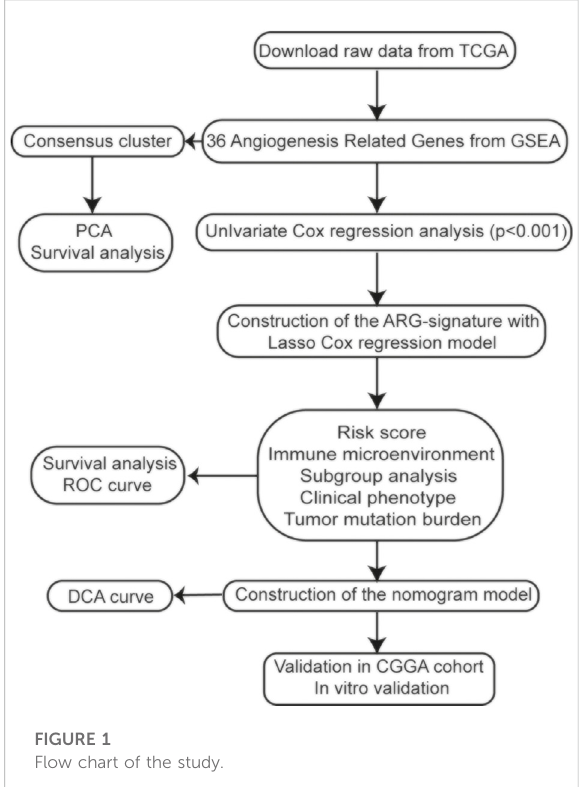
FIGURE 1 Flow chart of the